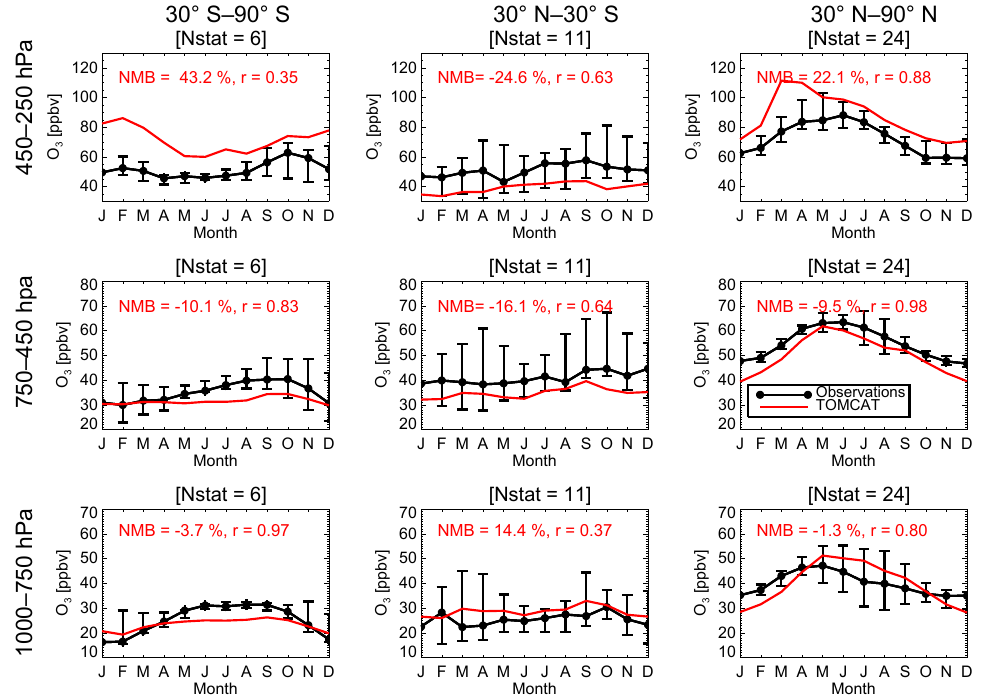
Figure 7. Median O 3 concentrations (ppbv) taken from the Tilmes et al. (2012) ozonesonde climatology compared to TOMCAT-simulated concentrations. The data are averaged over three latitude ranges (left to right) and three pressure level ranges (top to bottom), where the error bars show the 25th and 75th percentiles of the observed concentrations and Nstat gives the number of sonde release sites located within each latitude